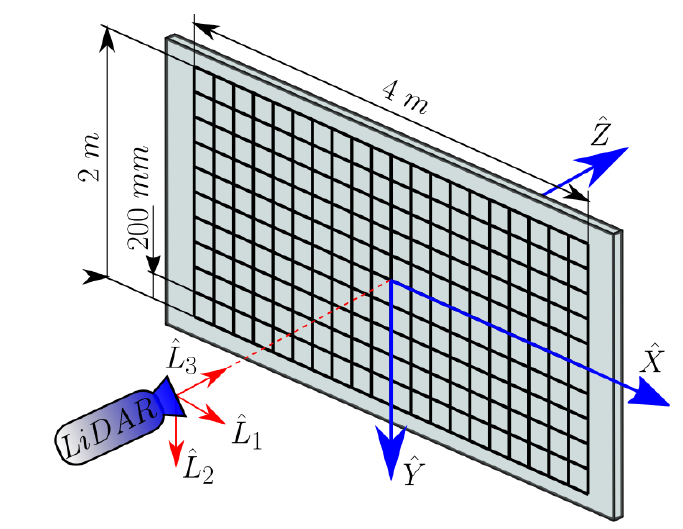
Figure 4. Scheme of the calibration pattern and position of the LiDAR.